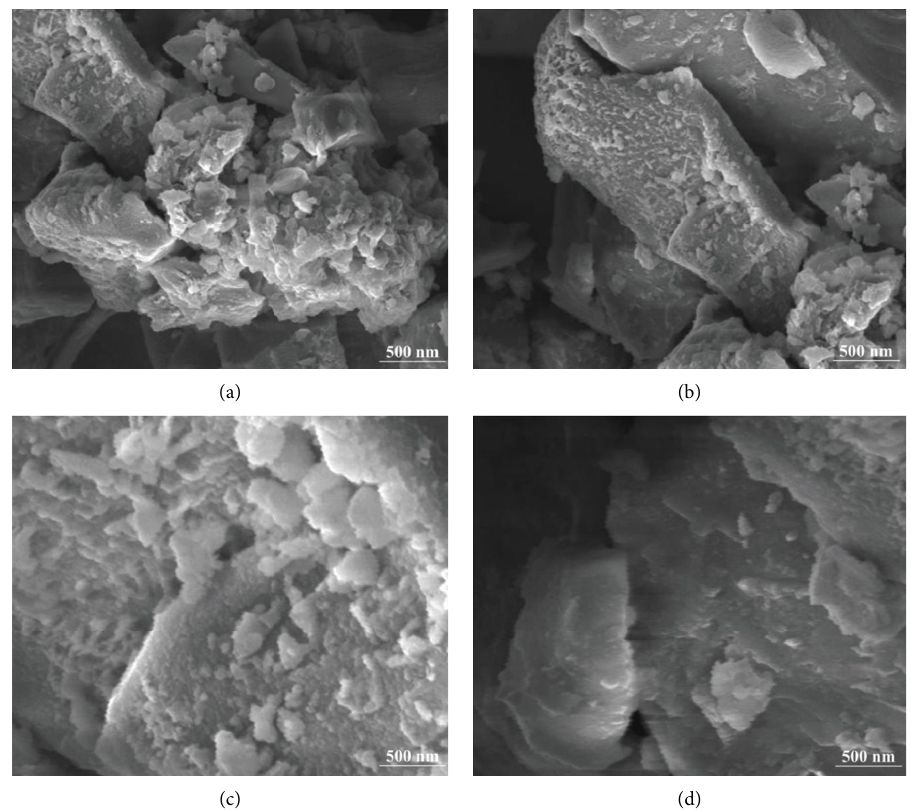
Figure 2: HR-SEM images of (a) pristine ZnCr 2 O 4 , (b) Zn 0.99 Mn 0.01 Cr 2 O 4 , (c) Zn 0.98 Mn 0.02 Cr 2 O 4 , and (d) Zn 0.97 Mn 0.03 Cr 2 O 4